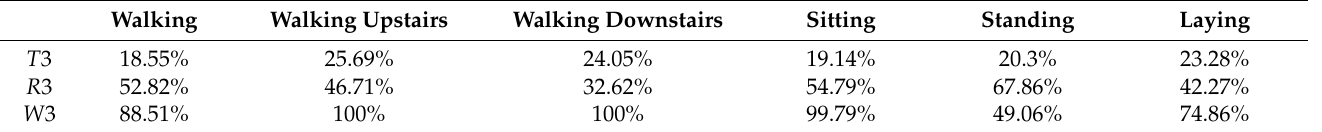
Table 2. Error rates on test data for each activity for the three feature subsets, T 3, R 3, and W